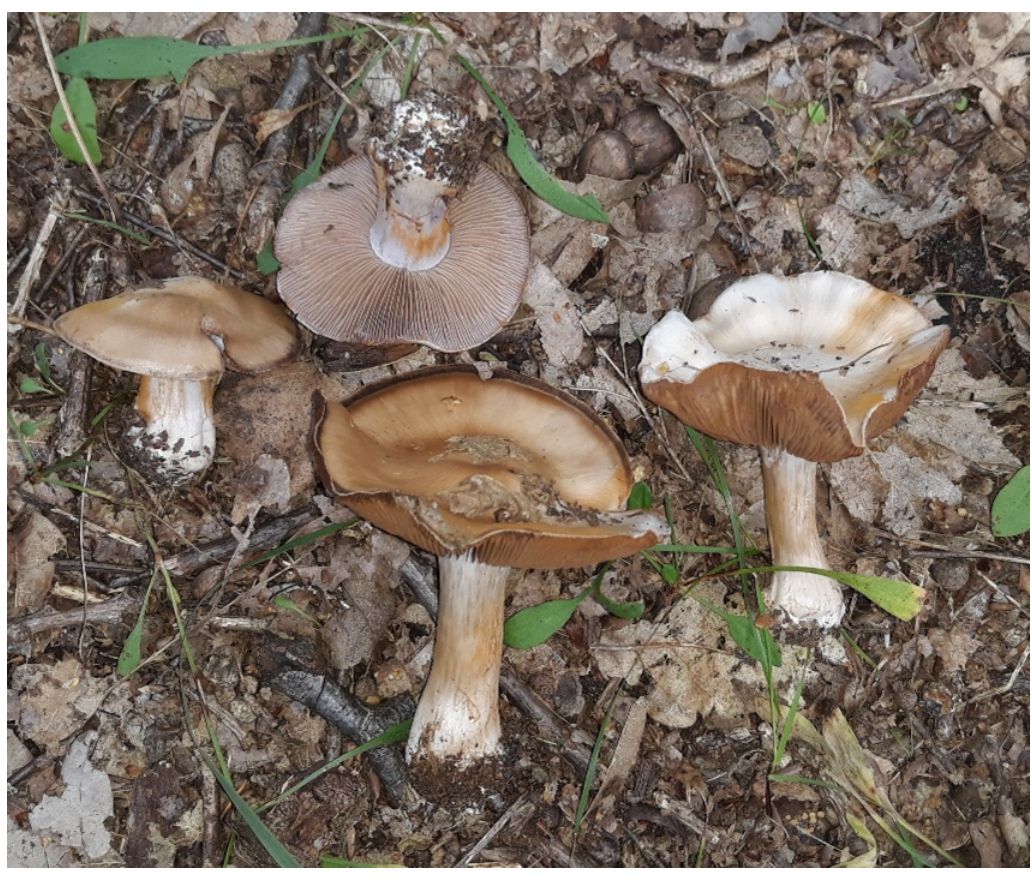
Figure 4 Basidiomata of Cortinarius subcompar from Kampinos National Park; September 4, 2021. Photography by T. Ślusarczyk.